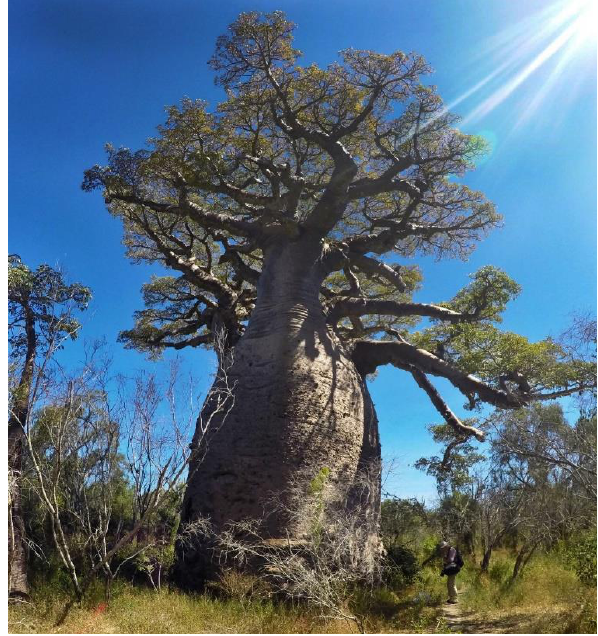
Figure 4. Image of A 257 presenting its eastern side with the shape of a bell jar.